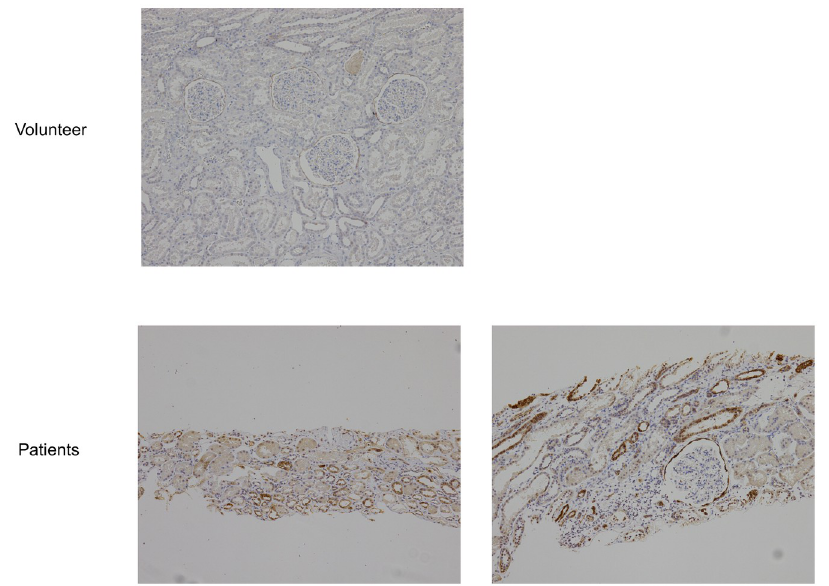
Fig 8. Increase of CL-1 expression in IgAN kidney. CL-1 expression was assessed using human kidney samples by IHC. CL-1 was expressed in PEC in kidney from a volunteer with renal cell carcinoma. In kidney from IgAN patients, CL-1 was expressed not only in PEC but also in proximal